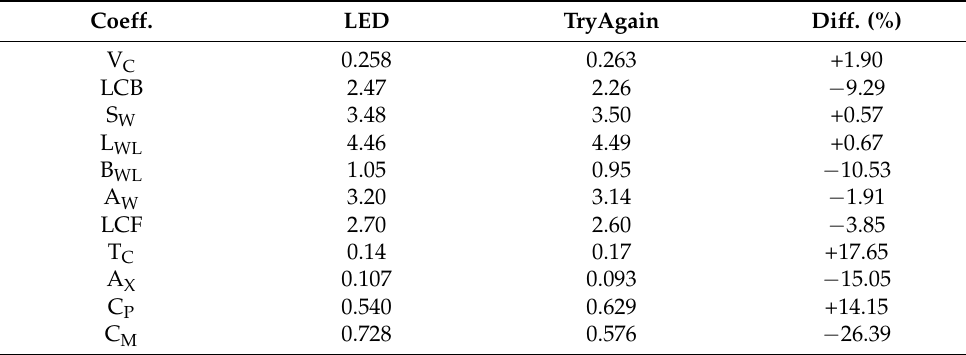
Table 2. Comparison between the coefficients of LED and TryAgain. Coeff. LED TryAgain Diff. (%) V C 0.258 0.263 +1.90 LCB